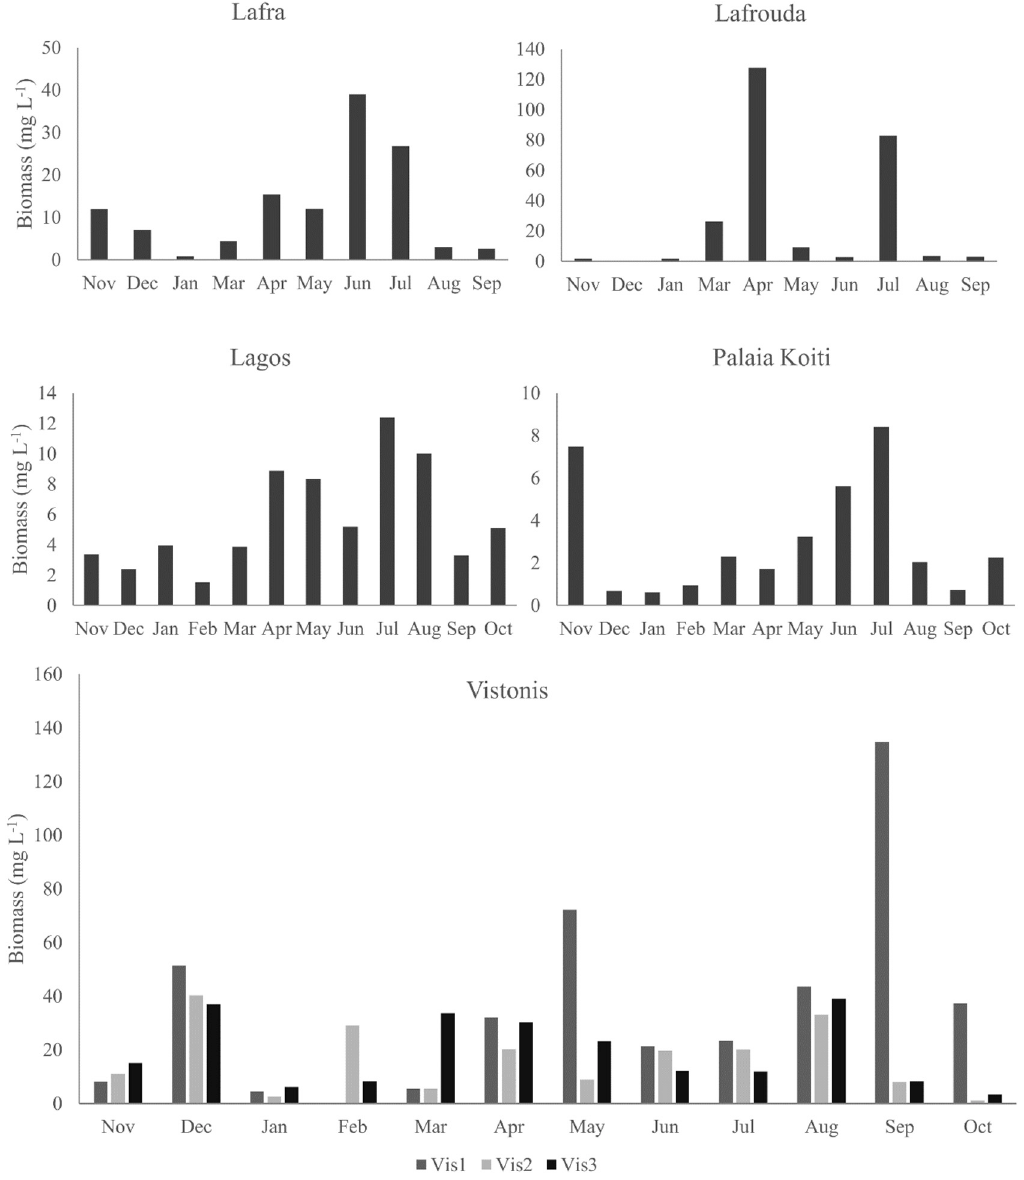
Figure 2. Total phytoplankton biomass in Lafra, Lafrouda, Lagos, Palaia Koiti and Vistonis lagoons during the period from November 2018 to October 2019.